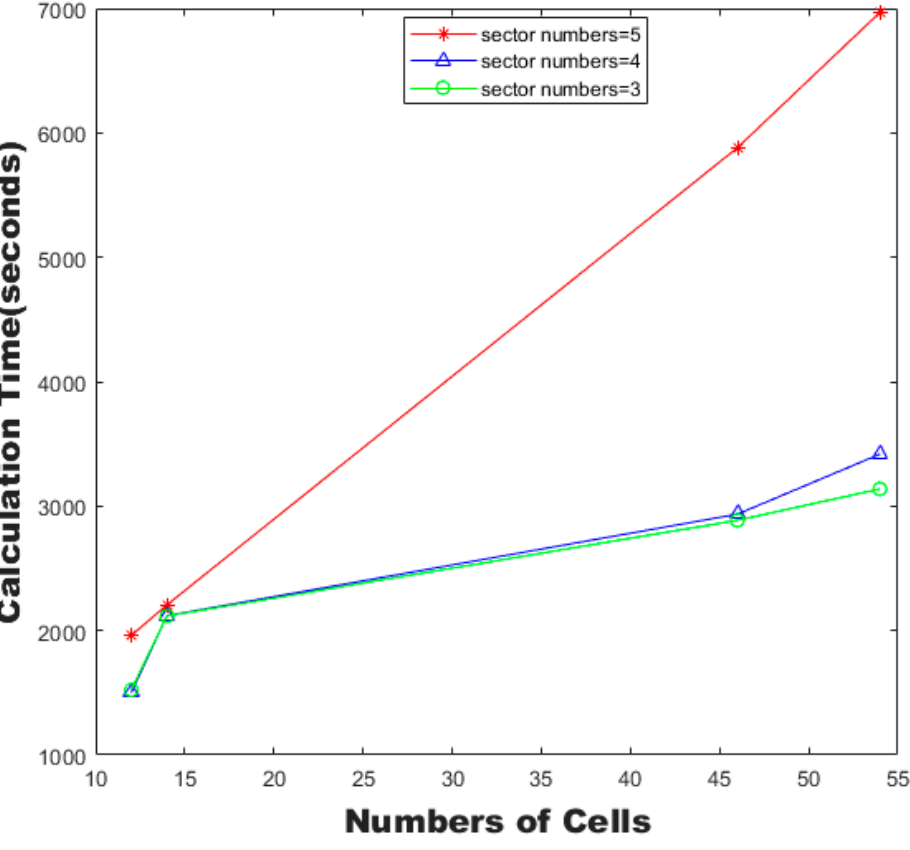
Figure 21. Calculation time of the SAA algorithm with different numbers of cells and sectors.